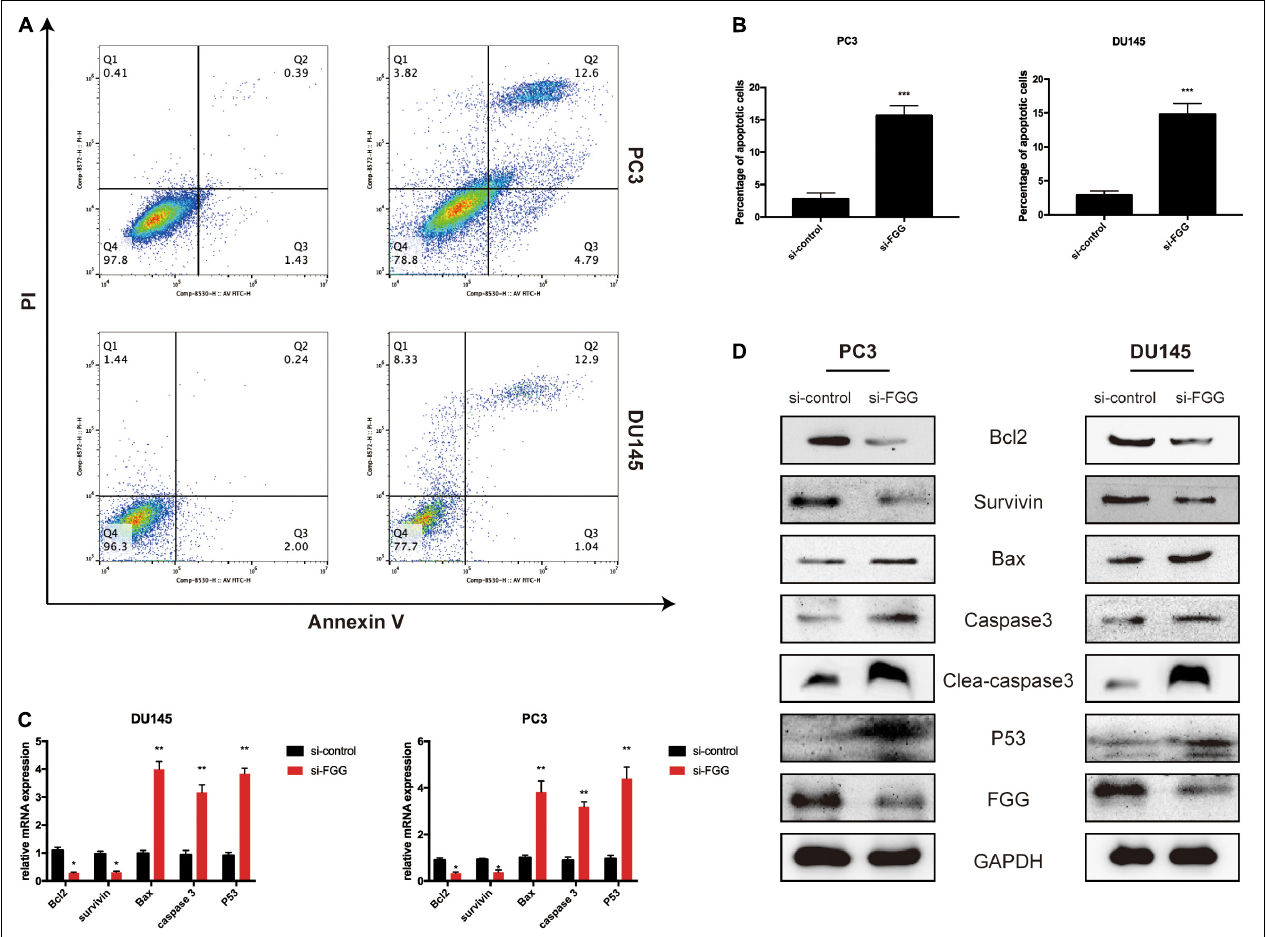
FIGURE 5 | Downregulation of FGG increases cell apoptosis. (A) Flow cytometry analyses revealed that the apoptosis ratio increased significantly after FGG knockdown in PC3 and DU145 cells. (B) The quantification of apoptotic ratio. (C) The relative mRNA expressions of apoptosis-associated factors in si-control/si-FGG PC3 and DU145 cells. (D) The relative protein expressions of apoptosis-associated factors in si-control/si-FGG PC3 and DU145 cells. * p < 0.05, ** p < 0.01, *** p <